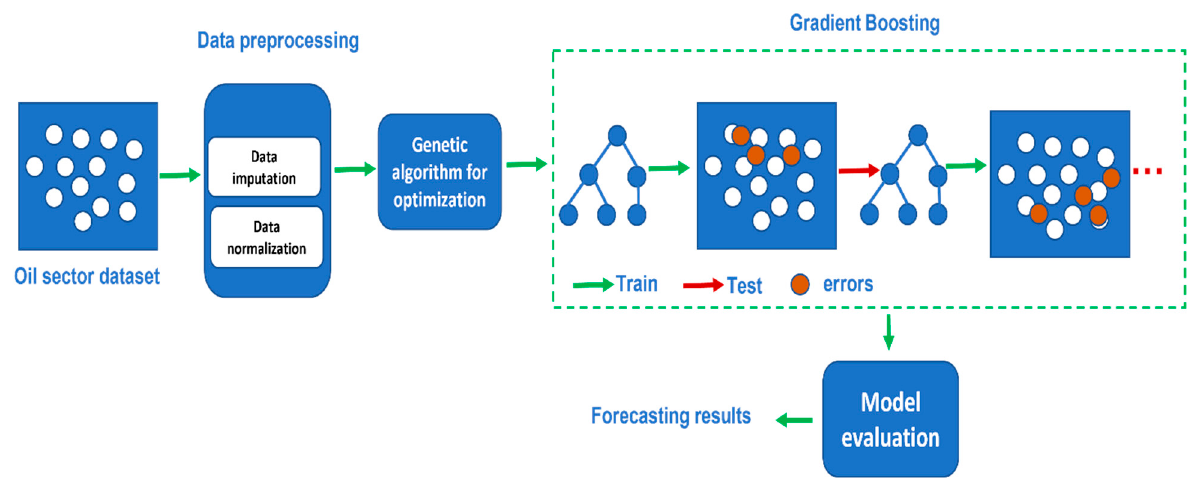
Figure 1. The stages of GA-GB forecasting model.